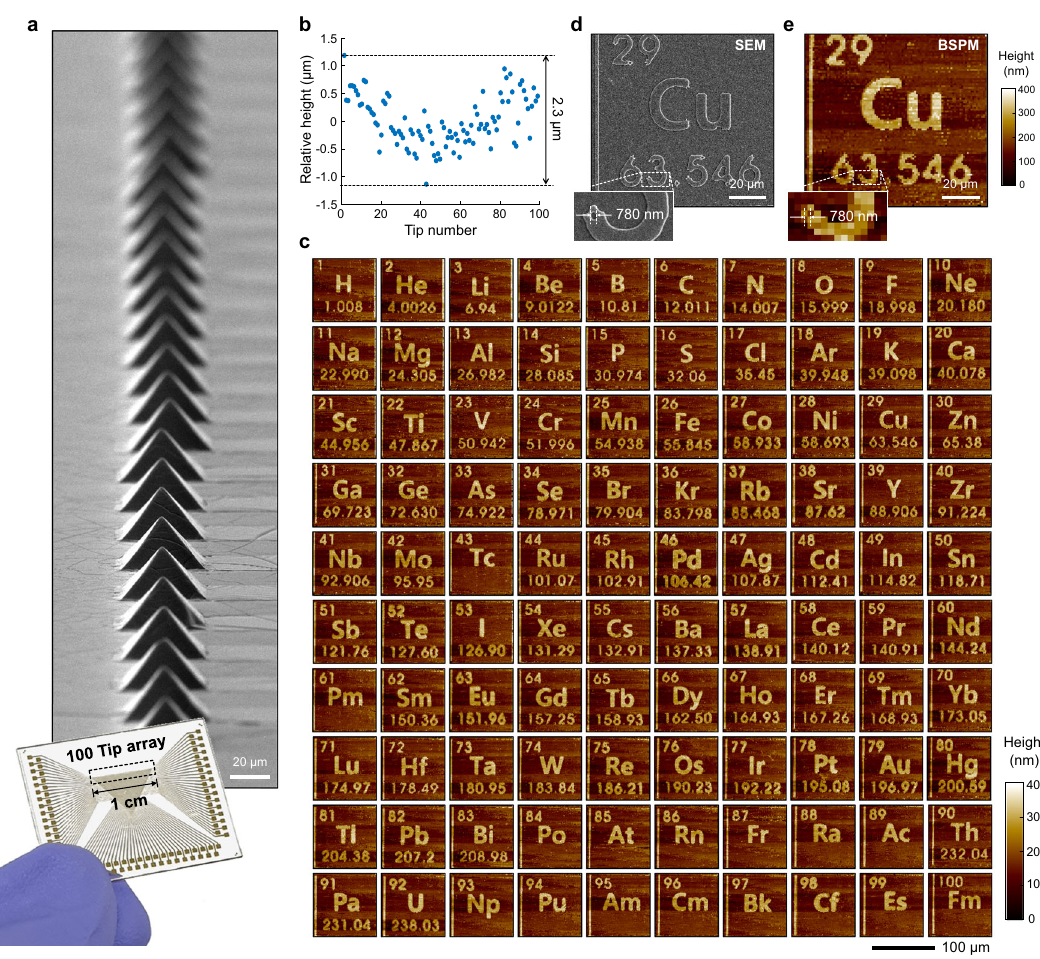
Fig. 5 Massively parallelized topography measurement using one hundred tips. a SEM image and photograph of the one-hundred-tip array. b Deviation of the one-hundred-tip array in the tip height. c Topography images of the periodic table patterns measured by the one-hundred-tip array. SEM ( d ) and BSPM ( e ) images of the copper portion of the periodic table